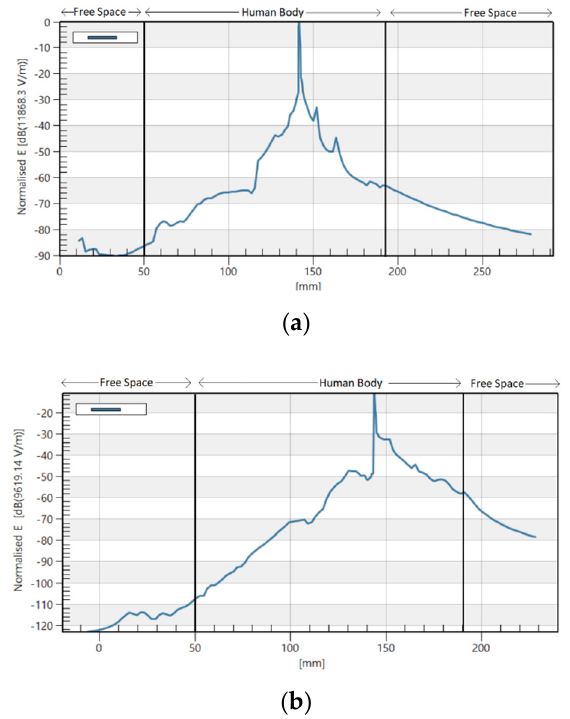
Figure 26. Attenuation of electric field along the x-cut of the female human phantom at ( a ) 402.5 MHz and ( b ) 2.45 GHz.